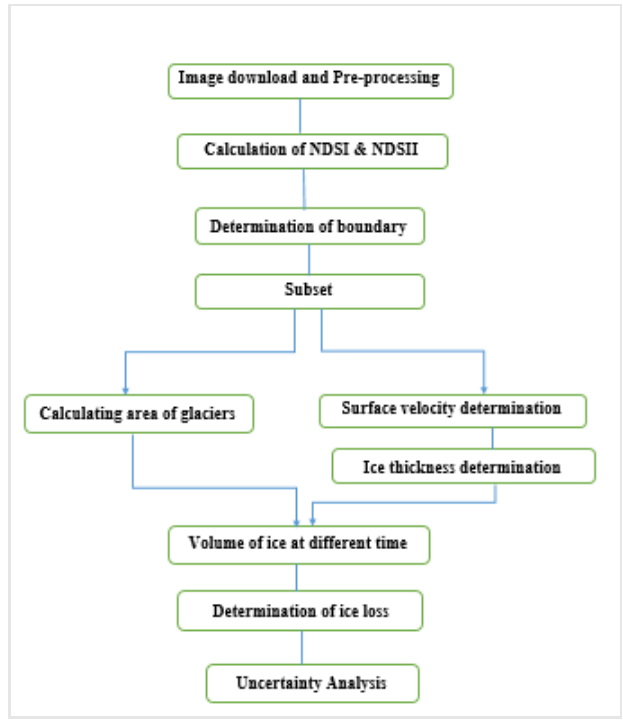
Figure 2. Workflow to determine volume of ice